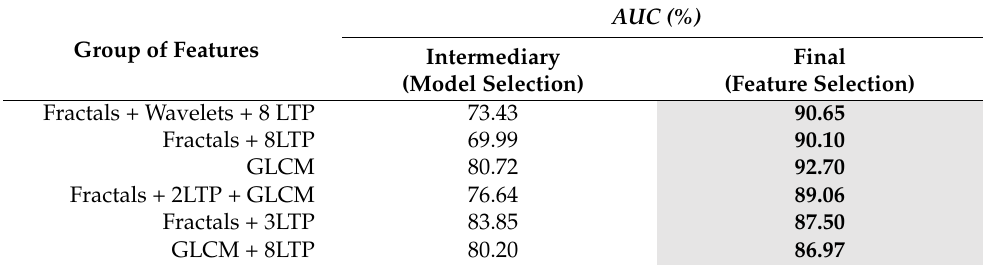
Table 10. AUC for Experiment 4: Results on model selection and on cancer detection.